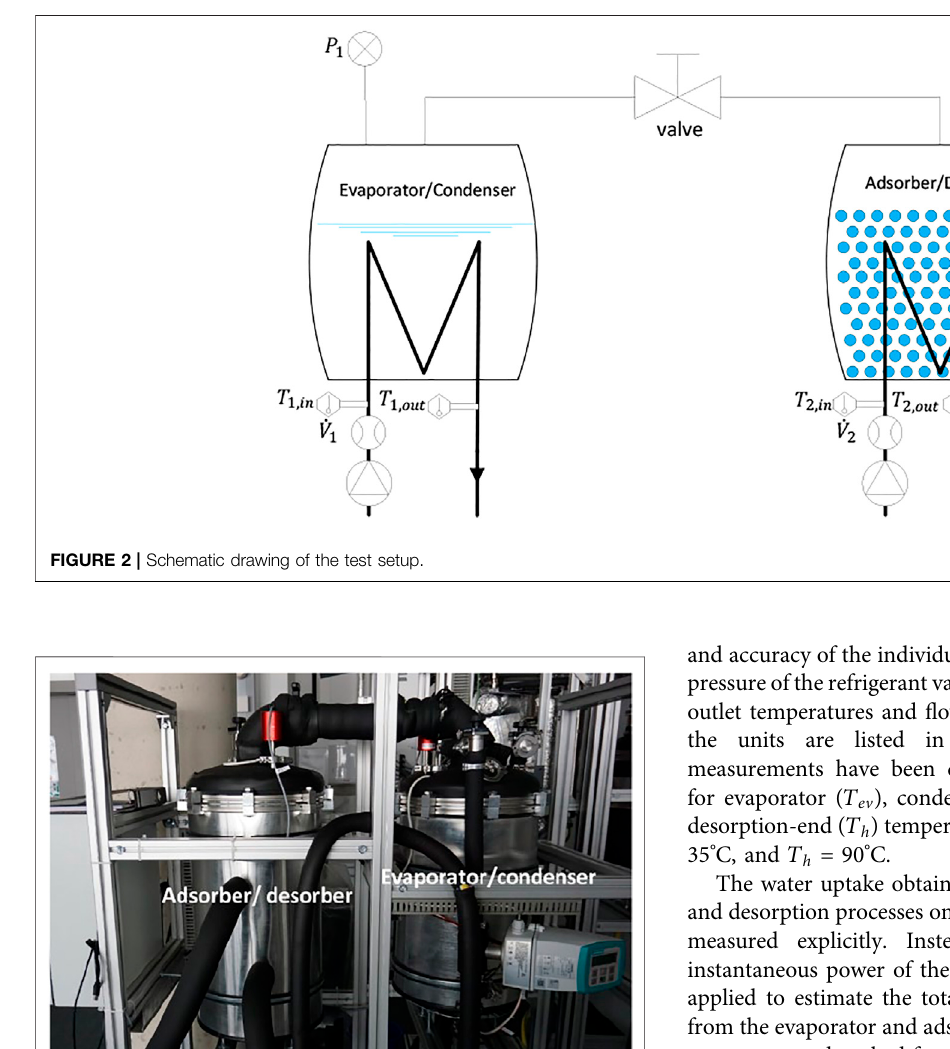
Frontiers in Energy Research |